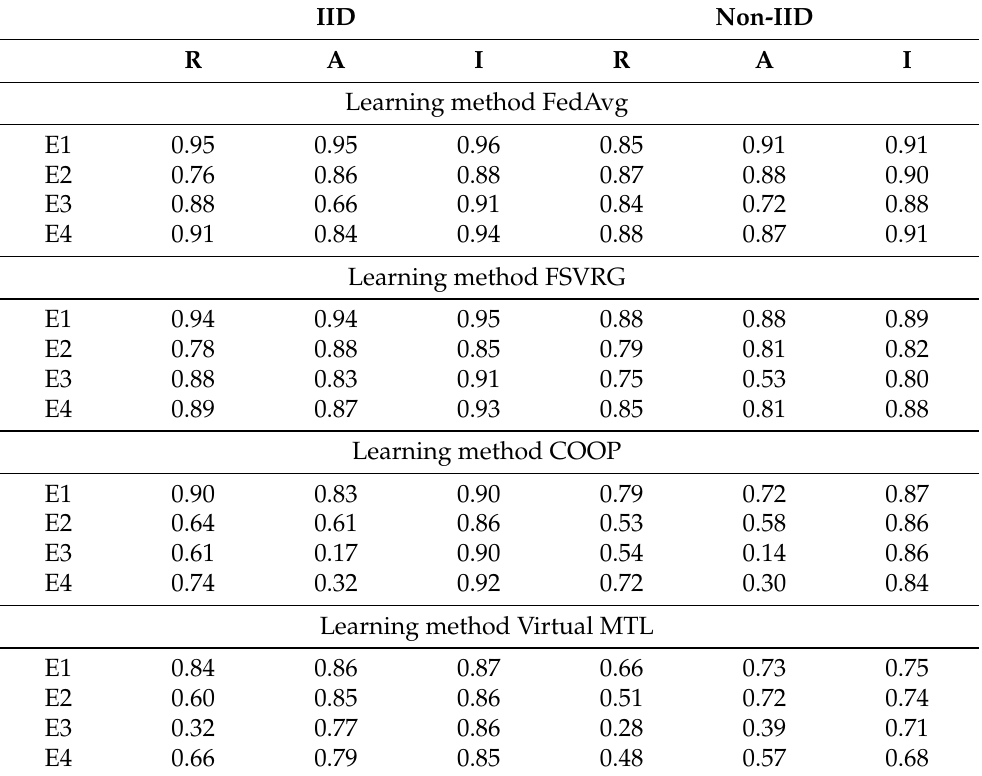
Table 5. Classification accuracies for dataset